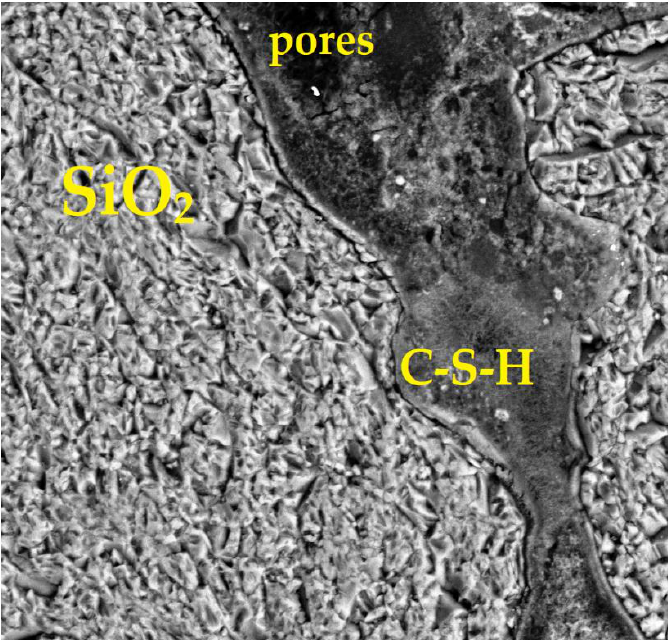
Figure 13. Scanning electron microscope (SEM) image of traditional sand-lime bricks (conataining Quartz Sand), SEM: low vaccum mode, 500× magnification.